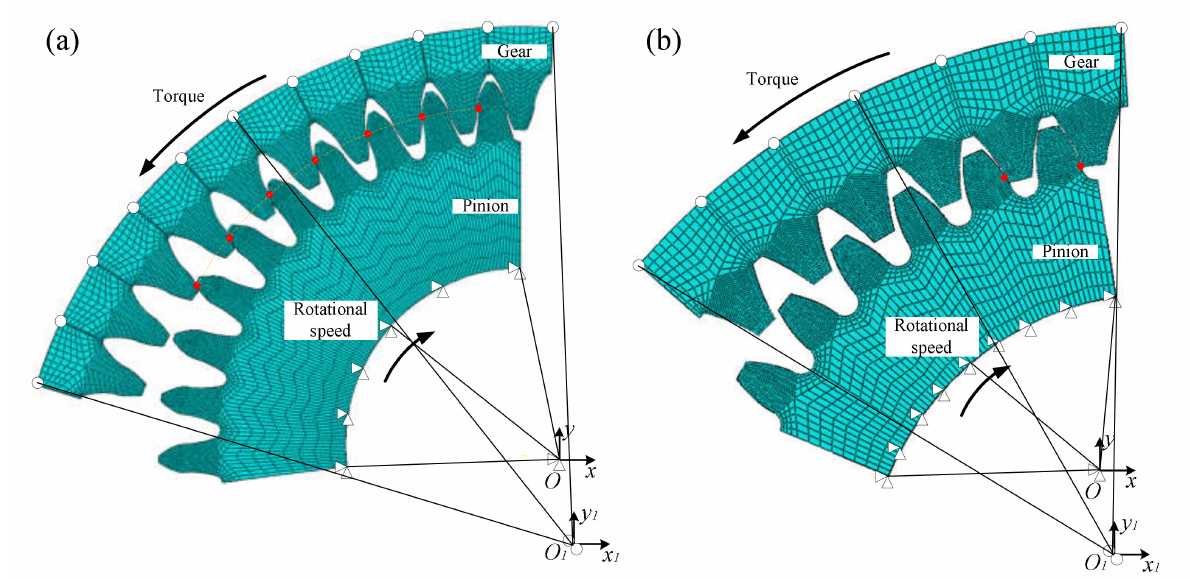
Figure 18. Schematic of the FEMs: ( a ) HCR internal spur gear pair, and ( b ) involute internal spur gear